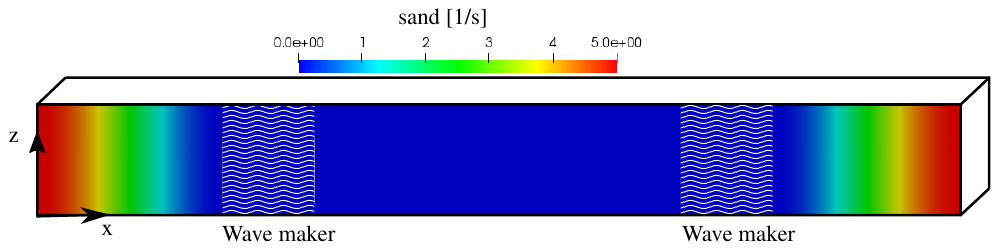
Figure 4. Definition of numerical beaches and wave maker regions.